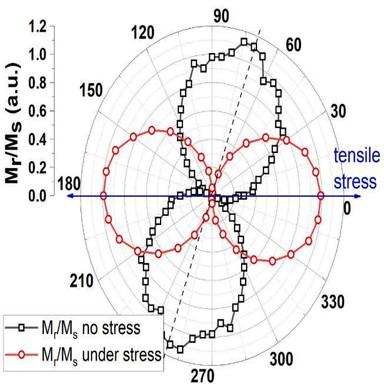
Angular dependence of the remanent magnetisation, Mr/Ms, of a 100 nm thick NiFe film measured with no stress (black squares) and under tensile stress (red circles).